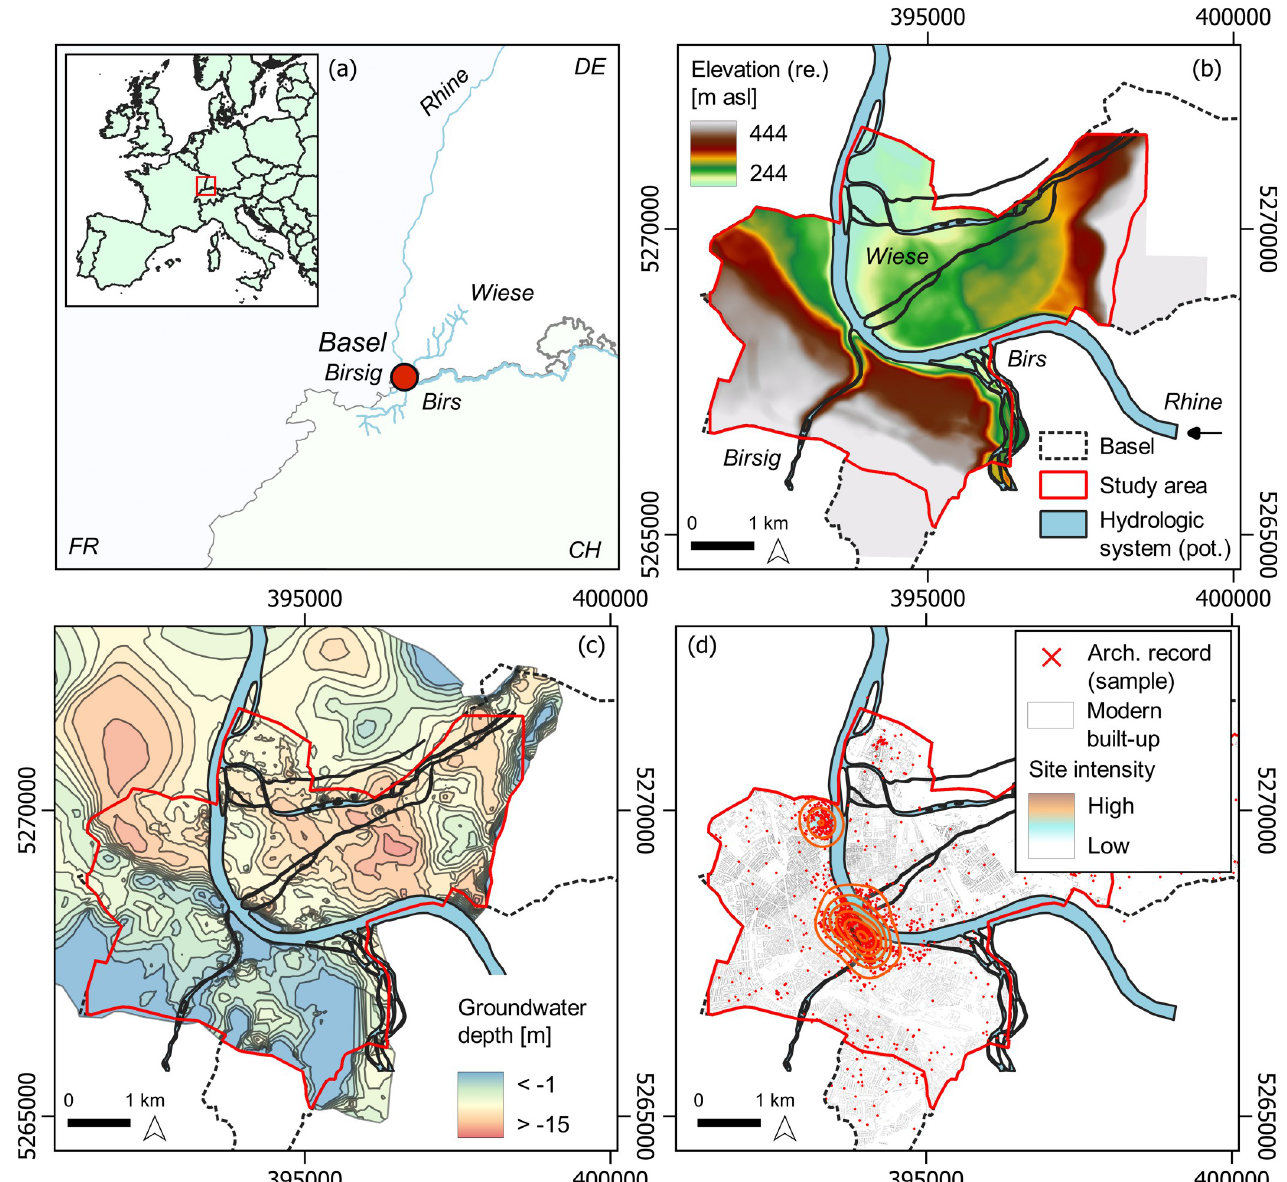
Fig 2. Environmental and urban settings of the study area. (a) Location of Basel (red circle); (b) reconstructed potential topographic and hydrologic conditions [75]; (c) groundwater level after drainage and channelization measures; (d) selected sample intensity of the total urban archaeological record at Basel (record excluding common era). Images are for illustrative purpose only. Data source: hydrologic streamflow derived from Open Street Map (OSM, https:// wiki.openstreetmap.org/wiki/Main_Page) data under https://creativecommons.org/licenses/by-sa/2.0/, last accessed 3 rd of November 2022). Administrative boundaries derived from the European Commission (EN: © EuroGeographics for the administrative boundaries, https://ec.europa.eu/eurostat/web/gisco/ geodata/reference-data/administrative-units-statistical-units/countries, last accessed 21 st of October 2022).